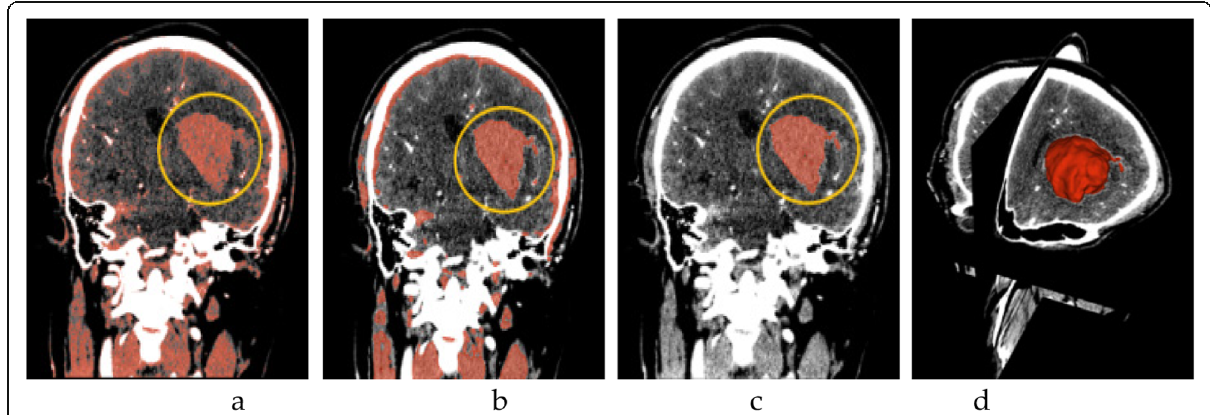
Fig. 1 Process of distinguishing the hematoma in the yellow circle. a Thresholding; b Using smoothing to optimize staining; c Using Islands to separate the hematoma; and d The fusion of the hematoma and the three-dimensional